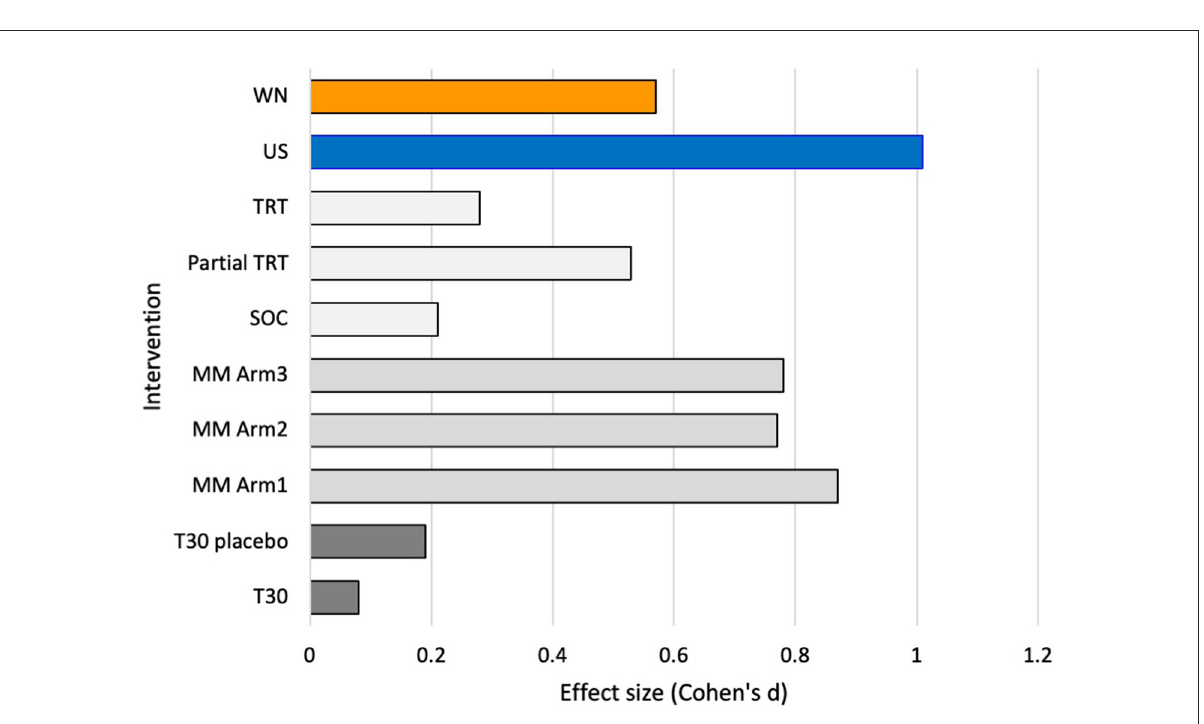
FIGURE9 Effect size (Cohen’s d ) for recent clinical trials at 12 weeks (3 months) of intervention. T30 stimulator trial (14), Multimodal (MM) sound and tongue stimulation trial (17), Tinnitus Retraining therapy (TRT) Partial TRT and Standard of Care trial (16), and current trial (WN, USL, intent-to-treat